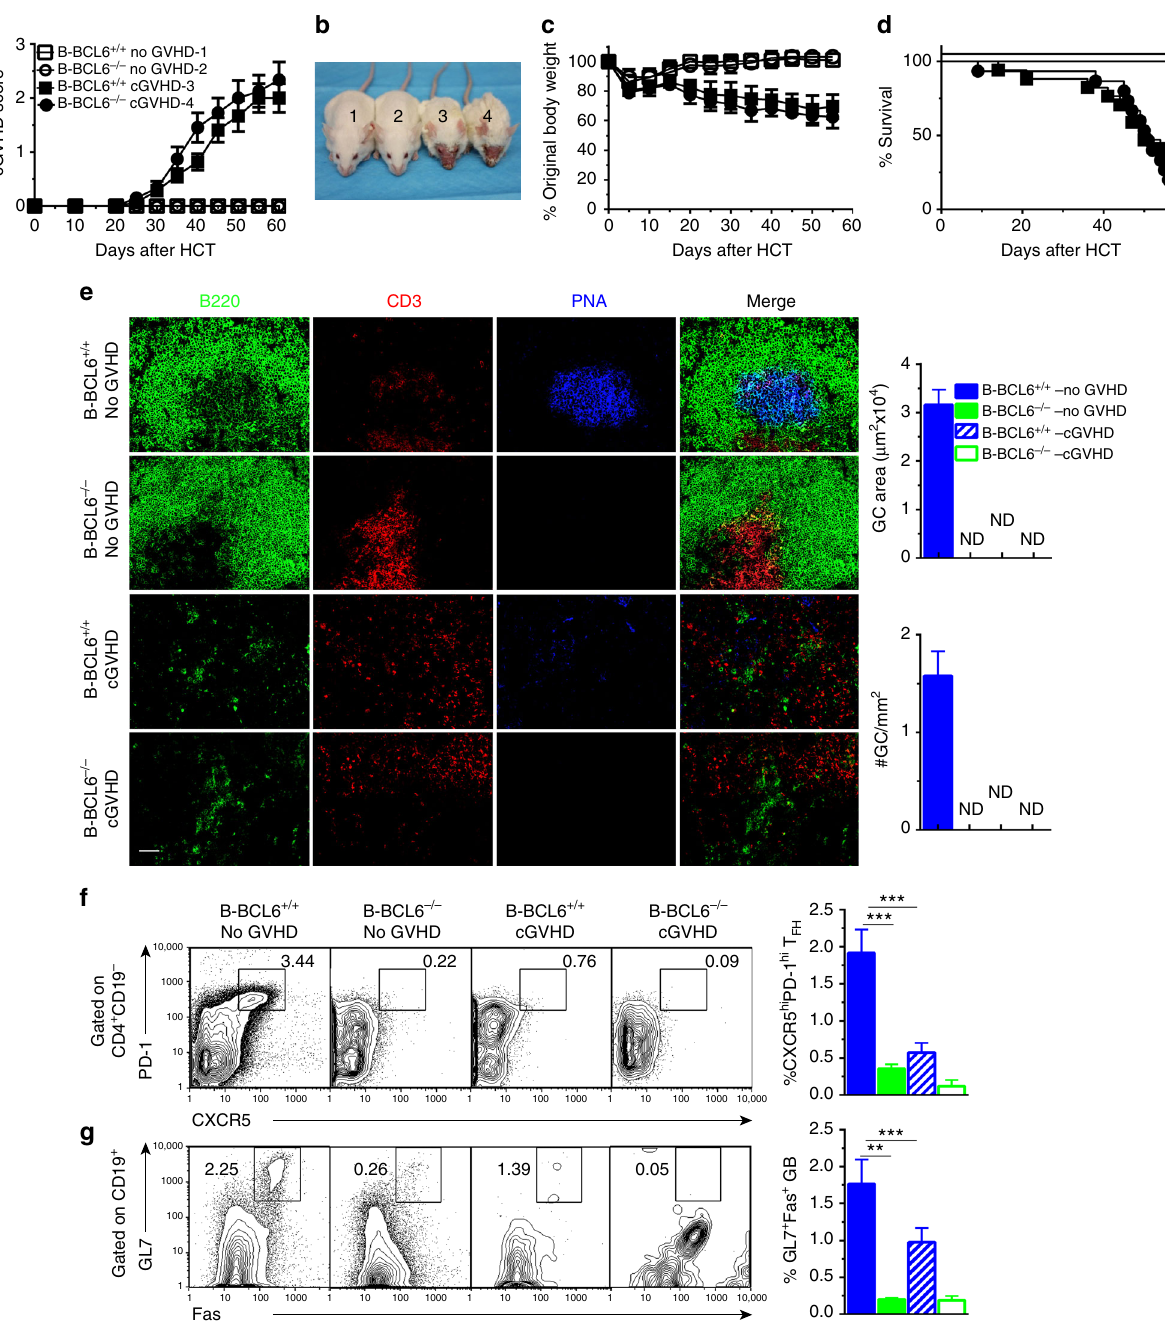
Fig. 2 Chronic GVHD was induced in recipients without germinal center formation. BALB/c recipients were irradiated (850 cGy) and given 2.5 × 10 6 TCD- BM alone ( n = 12) or 2.5 × 10 6 TCD-BM plus 1 × 10 6 ( n = 12) splenocytes from either WT C57BL/6 or BCL6 fl / fl Mb1-Cre C57BL/6 donors. cGVHD development was monitored. a Cutaneous cGVHD score. b Picture taken at day 60 after HCT (1 and 3 – B-BCL6 +/+ no GVHD and cGVHD, 2